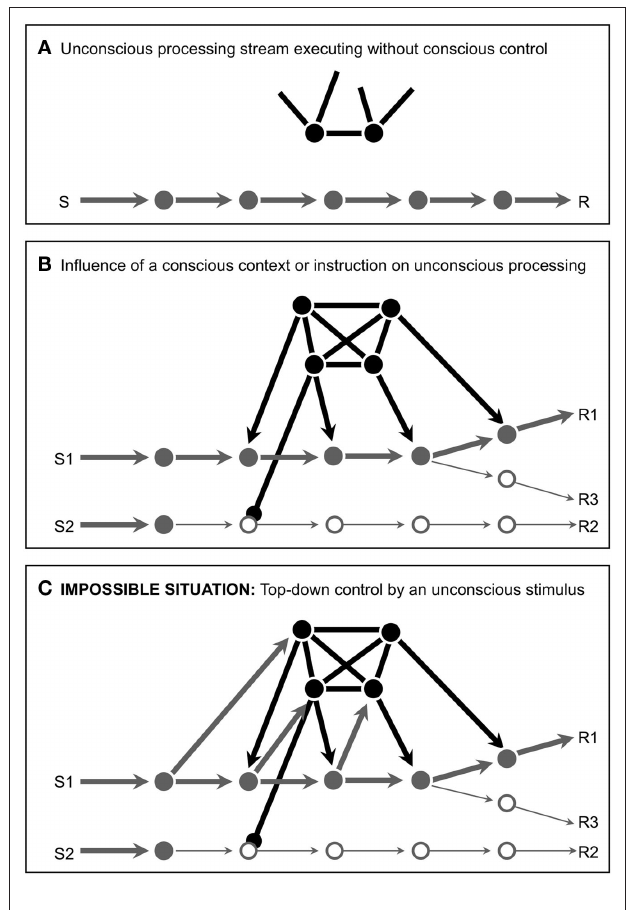
Figure 3 | Since the study by Merikle, unconscious processes are said to be unable to influence conscious processing without being reportable, after Dehaene and Naccache (2001). (A) Unconscious processing stream executing without conscious control. (B) Influence of a conscious context or instruction on unconscious processing. (C) Impossible situation: top-down control by an